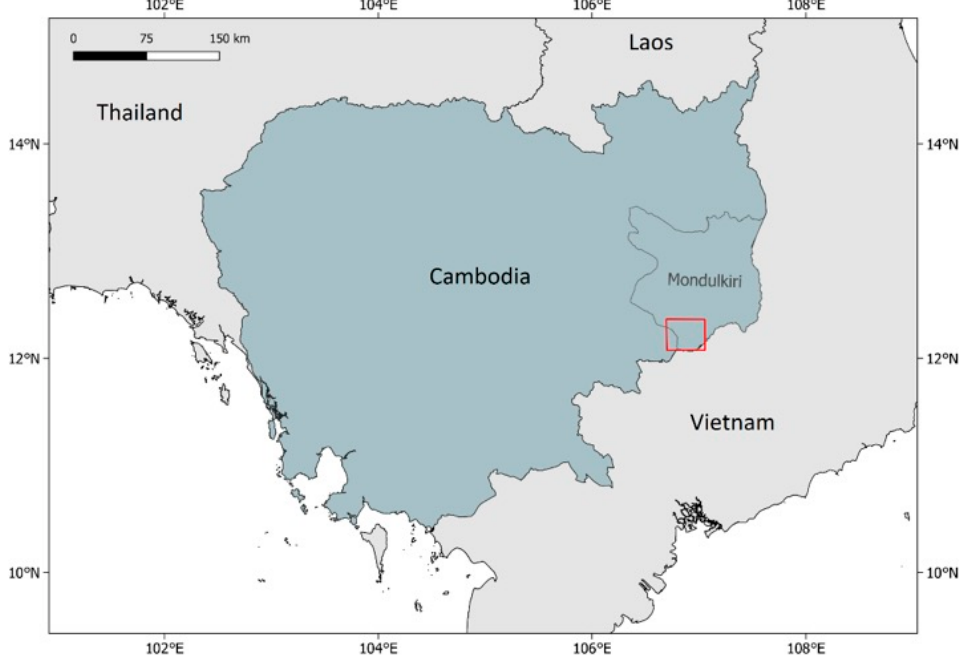
Figure 3. Location of Mondulkiri province and study area (red rectangle).